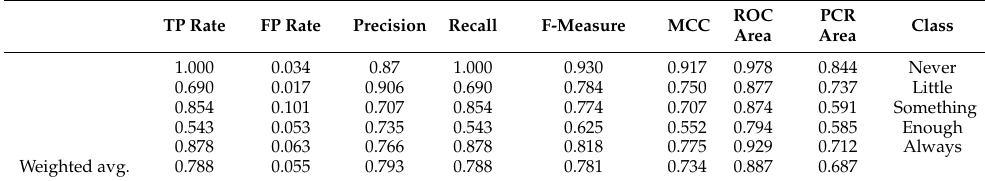
Table 17. Detailed accuracy by class.